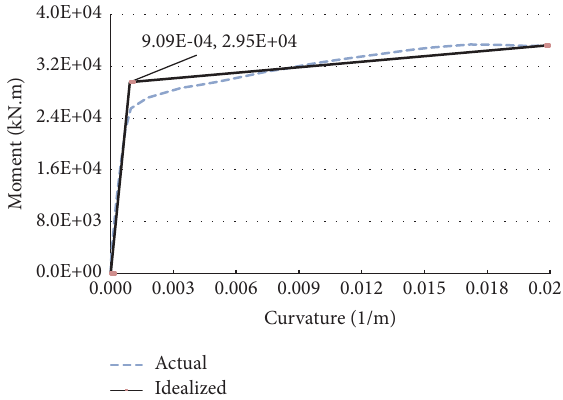
Figure 15: Yield fexural capacity of 20cm wall with fnal distribution of reinforcements. Table 15: Comparison of walls’ curvature by MMPD ( F